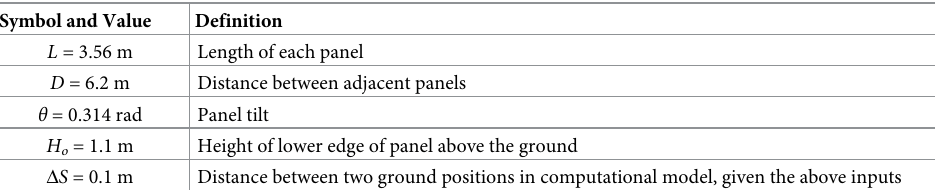
Table 1. Panel geometry parameters.